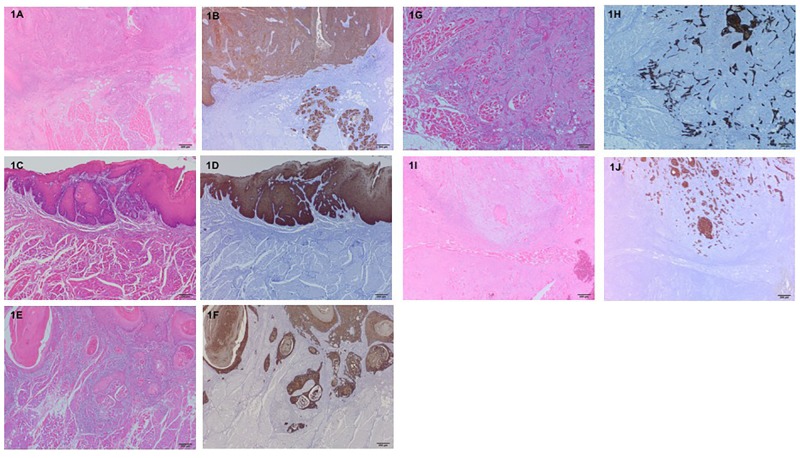
Representative photographs of classification of mode of invasion (H&E staining, immunohistochemical pancytokeratin staining, x40 magnification).(1A,1B) grade 1, (1C,1D) grade 2, (1E,1F) grade 3, (1G,1H) grade 4C, and (1I,1J) grade 4D.